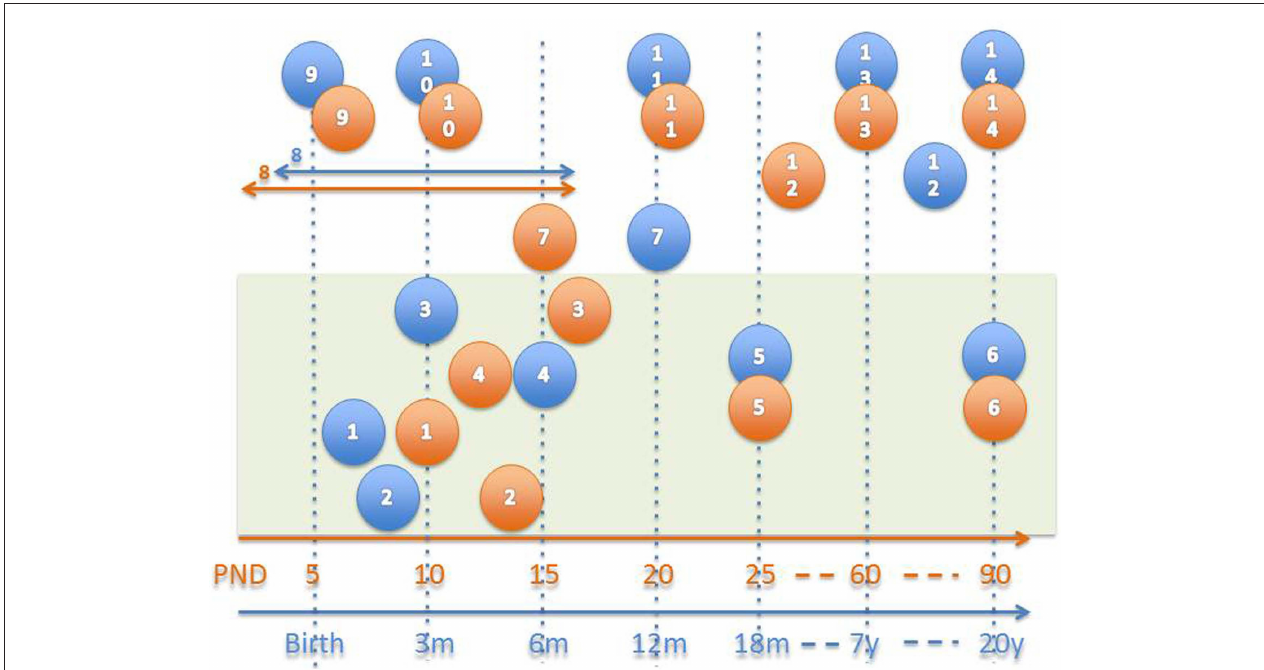
Figure 1 | Approximate neuro-development comparison in humans (blue) and rats (orange; Watson et al., 2006) . 1–6 = Myelination, 1 = myelination onset internal capsule, 2 = onset olfactory tract, 3 = onset anterior commissure, 4 = onset fornix, 5 = 50% myelination of corpus callosum, 6 = mature